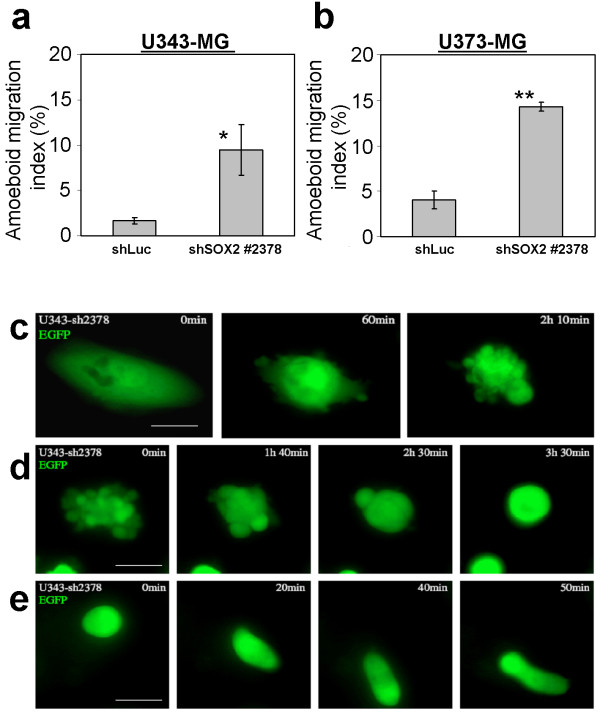
SOX2-RNAi induces morphological changes in glioma cells. Trans well assay using membranes lacking the ECM for determination of proteolysis-independent amoeboid-like migration of a: U343-MG and b: U373-MG cells with knock down of SOX2. The calculation of the amoeboid-like migration index was performed as described in the material and methods section. Bars indicate standard deviation. * p < 0.05; ** p < 0.01 when cells with knockdown of SOX2 were compared to shLuc controls. c-e: U343-MG cell transduced with shSOX2 #2378 and expressing the marker EGFP were monitored by life cell imaging. c: An adherent cell with normal cell morphology develops protrusions of the membrane which appear as little blebs. d: An intensive blebbing cell develops less frequent, but larger blebs, and acquire a round cell morphology; e: A fully rounded cell contracts the cell body and migrates. Magnification bars: 30 μm.